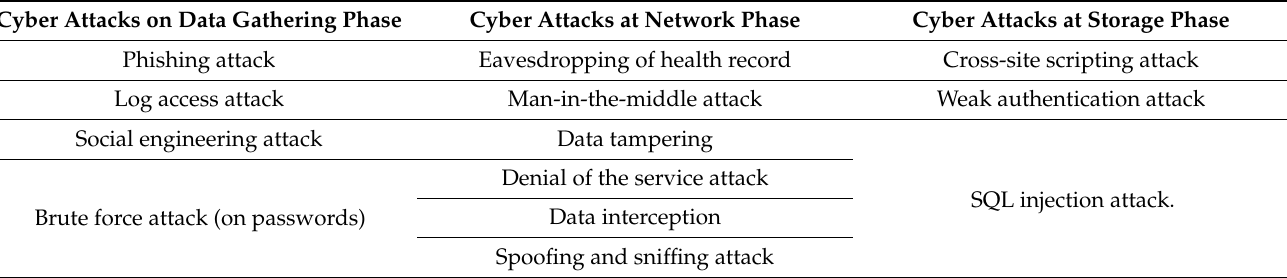
Table 8. Cyberattacks presented in the Indian healthcare